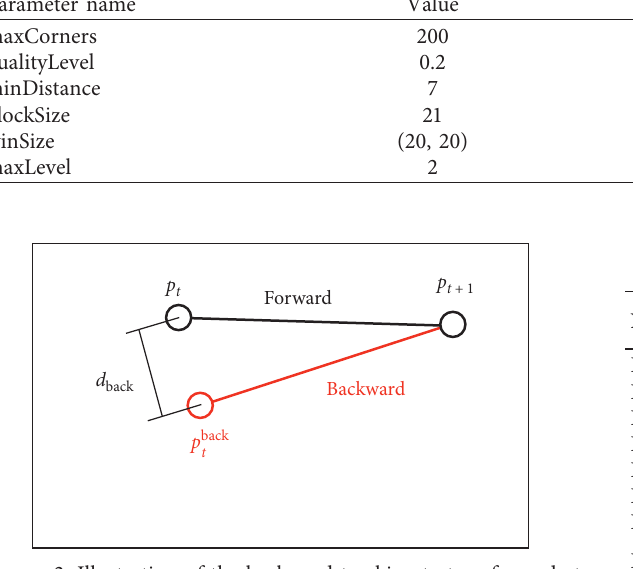
Figure 2: Illustration of the backward tracking test performed at each time step for all features.